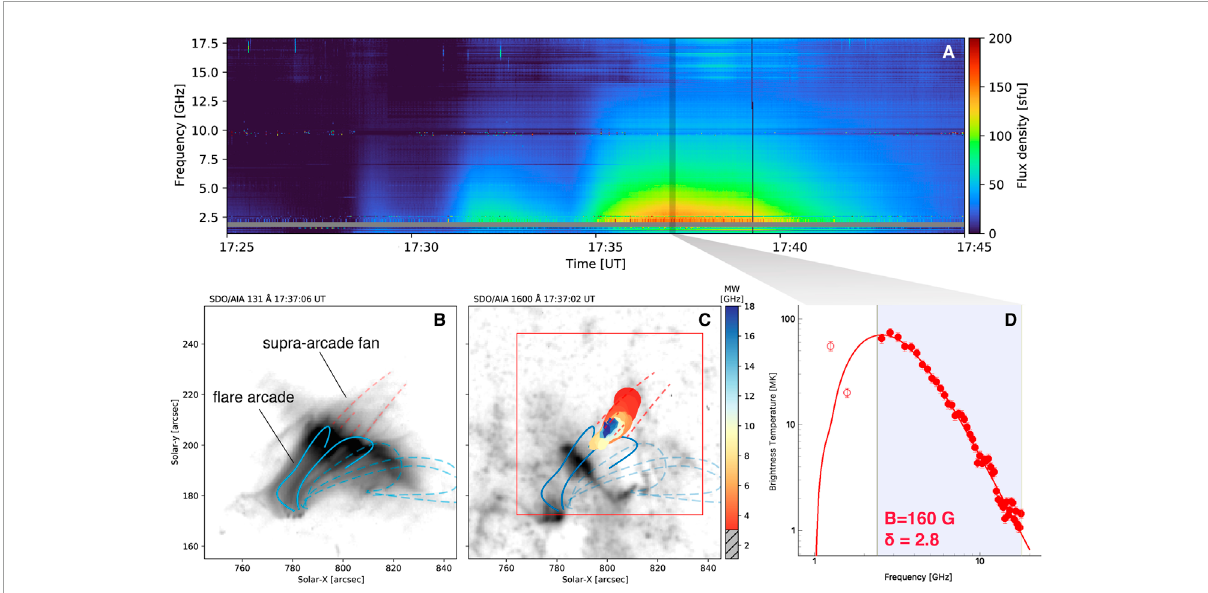
FIGURE 8 EOVSA dynamic spectroscopic imaging of the looptop microwave source of the 18 January 2022 flare. Panel (A) shows EOVSA total (sun-as-a-star) power microwave dynamic spectrum of the flare in 1–18GHz. In panel (B) , reconstructed flare loops also shown in Figure 7 are overplotted atop of AIA 131Å image. The red dashed curves denote the supra-arcade fan structure. The same flare loops and fan structure are indicated in panel (C) with the AIA 1600Å snapshot in the background. Between the apices of the two solid flare loops, sources of EOVSA microwave emission at 17:37 UT are plotted as contours corresponding to the 95% of the peak brightness at each frequency (decreasing from blue to red). Panel (D) presents the microwave brightness temperature spectrum T B ( ν ) (red circles) obtained in the region denoted using the red box in panel (C) . Each T B ( ν ) value at a given frequency ν represents the maximum brightness temperature within the region. The red solid curve is the best-fit model based on non-thermal gyrosychrontron emission. The vertical white shaded area indicates the frequency range excluded from the spectral fit. The best-fit magnetic field strength B and the power-law index δ of the non-thermal electron energy distribution are also